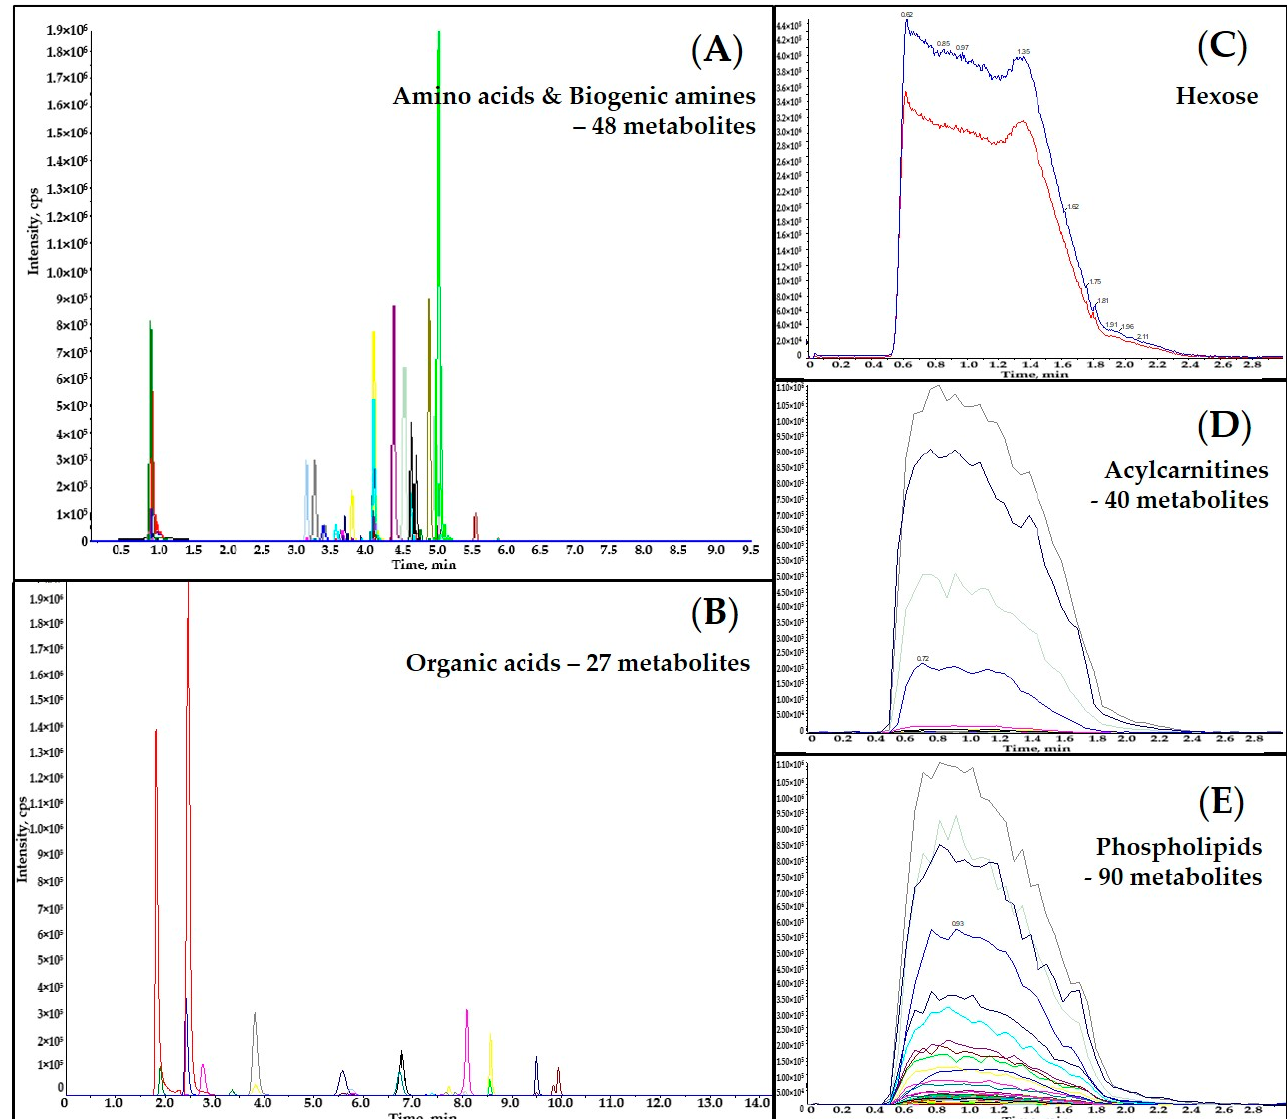
Figure 1. Overlaid representative Extracted Ion Chromatograms (EICs) of analyzed metabolites and ISTDs in an extracted pine needle sample: ( A ) EICs of amino acids, biogenic amines and their derivatives; ( B ) EICs of organic acids; ( C ) EICs of hexose; ( D ) EICs of acylcarnitines; ( E ) EICs of phospholipids.